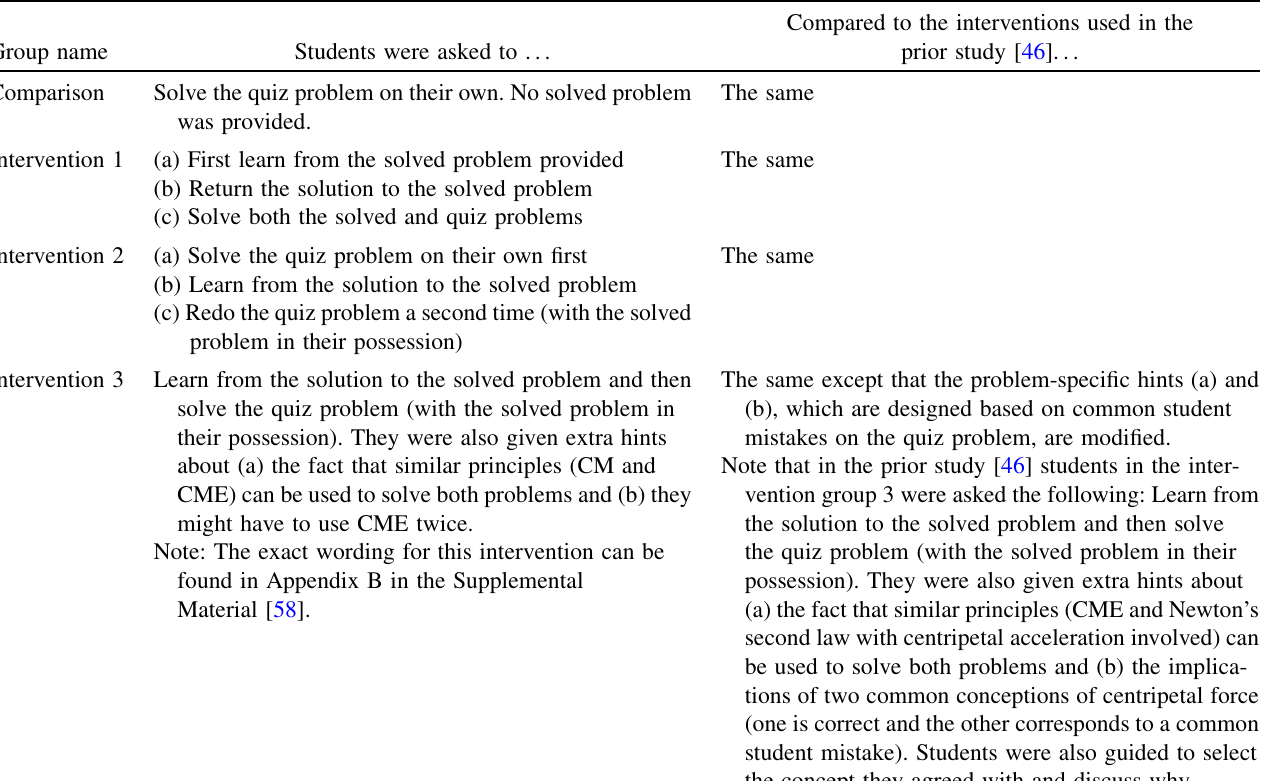
TABLE I. Summary of the different interventions used in this